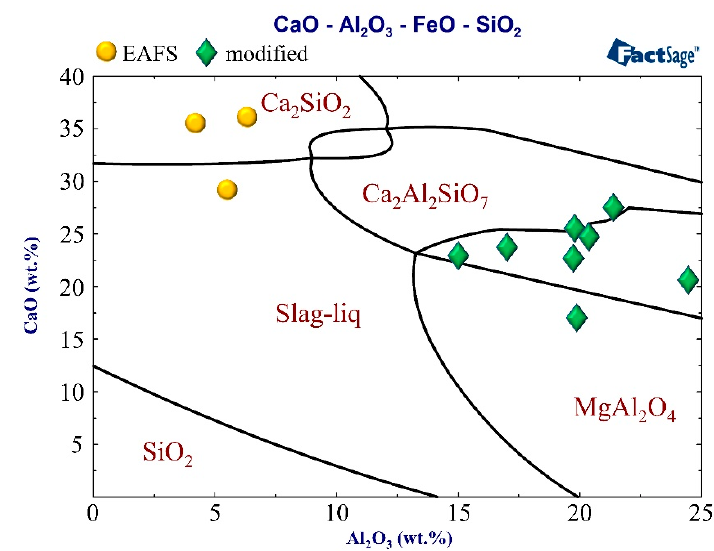
Figure 7. Samples identified on the CaO–40FeO–SiO 2 –Al 2 O 3 system at 1250 °C.